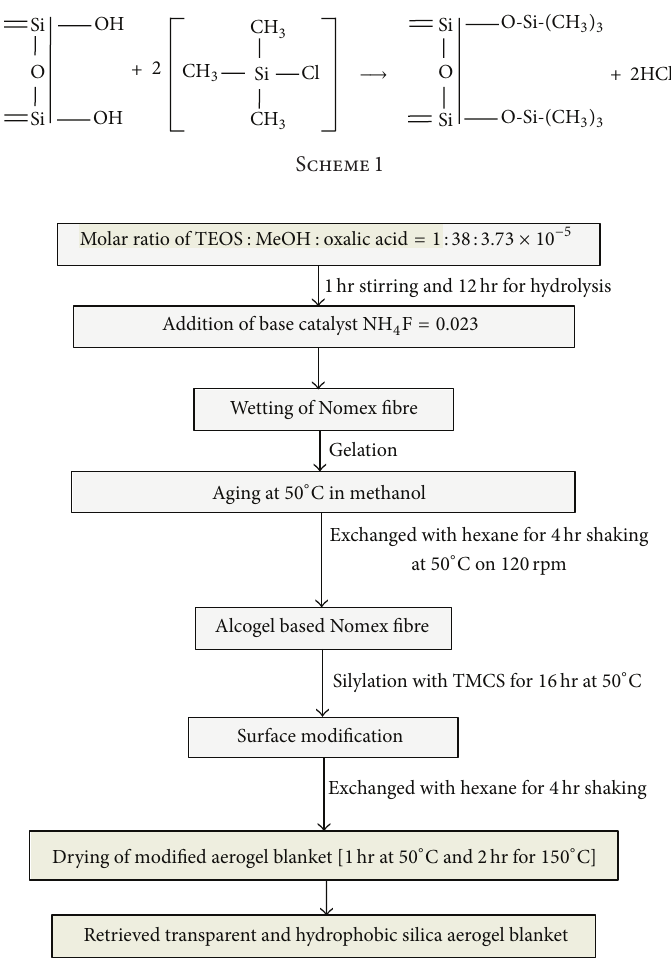
Figure 1: Flow chart of the experimental procedure for the preparation of the aerogel blanket.